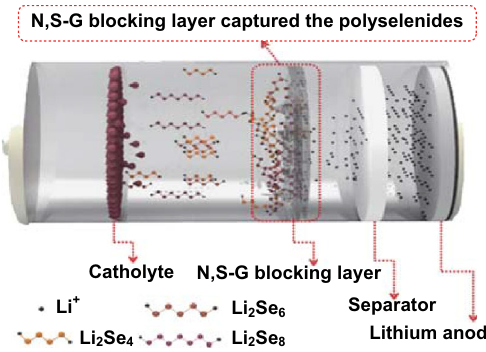
Fig. 1 N,S-G membrane as an interlayer for trapping